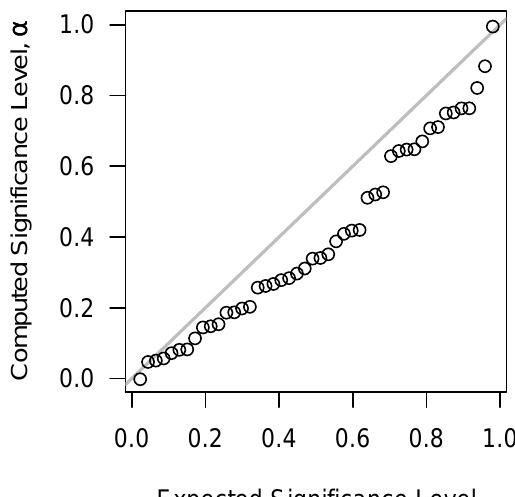
llllllllllllllllllllllllllllllllllllllllllllll Fig. 4. Uniform probability plot of local significance levels α re- ported in Table 2. Here the uniform PPCC r = 0 . 9852 and the 5% critical value is r 0 . 05 = 0 .